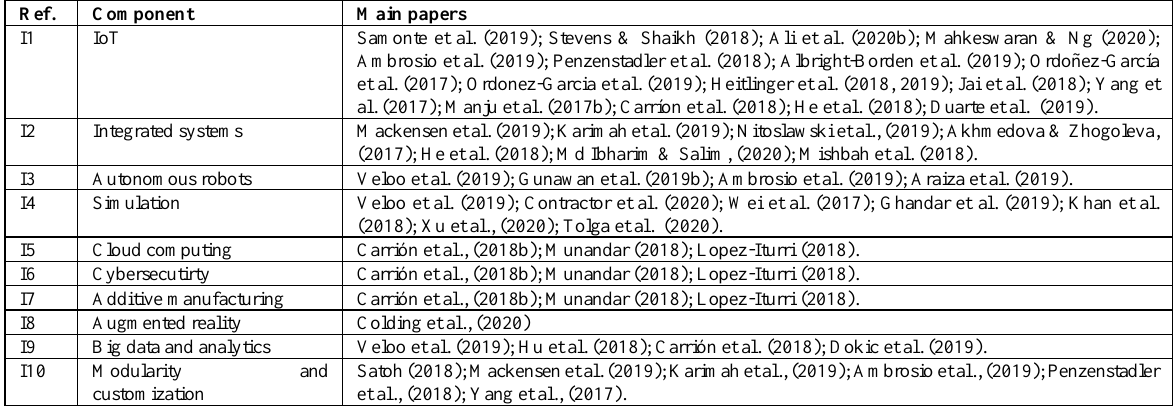
Table 4. Key technologies of Industry 4.0 and main related papers identified by the systematic literature review. The corresponding codes were used in the relationship